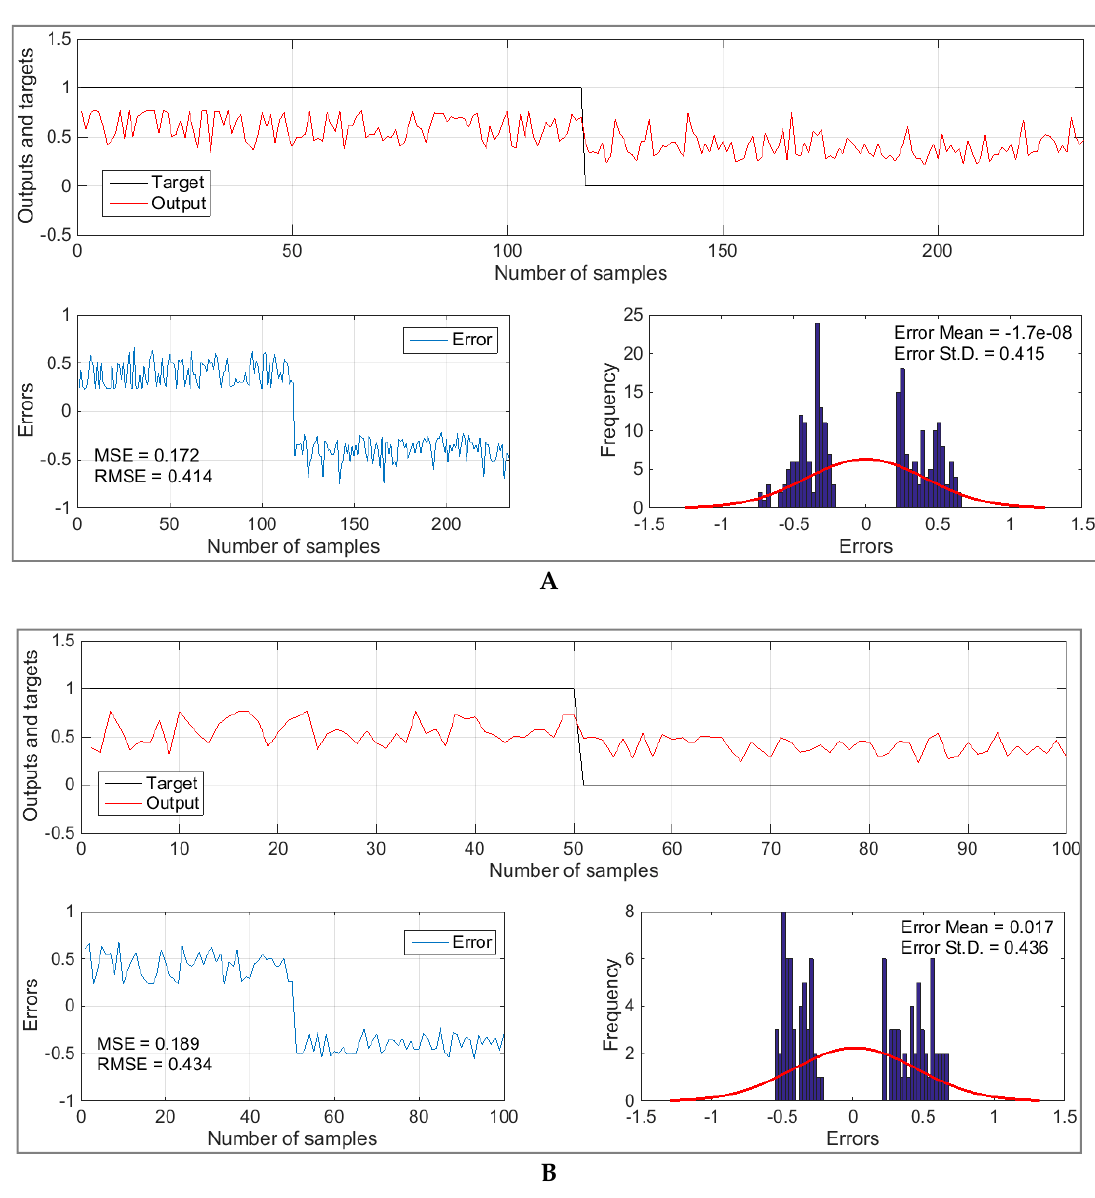
Figure 7. Analysis of errors of the RFBFDT model using ( A ) the training dataset and ( B ) the validating dataset.